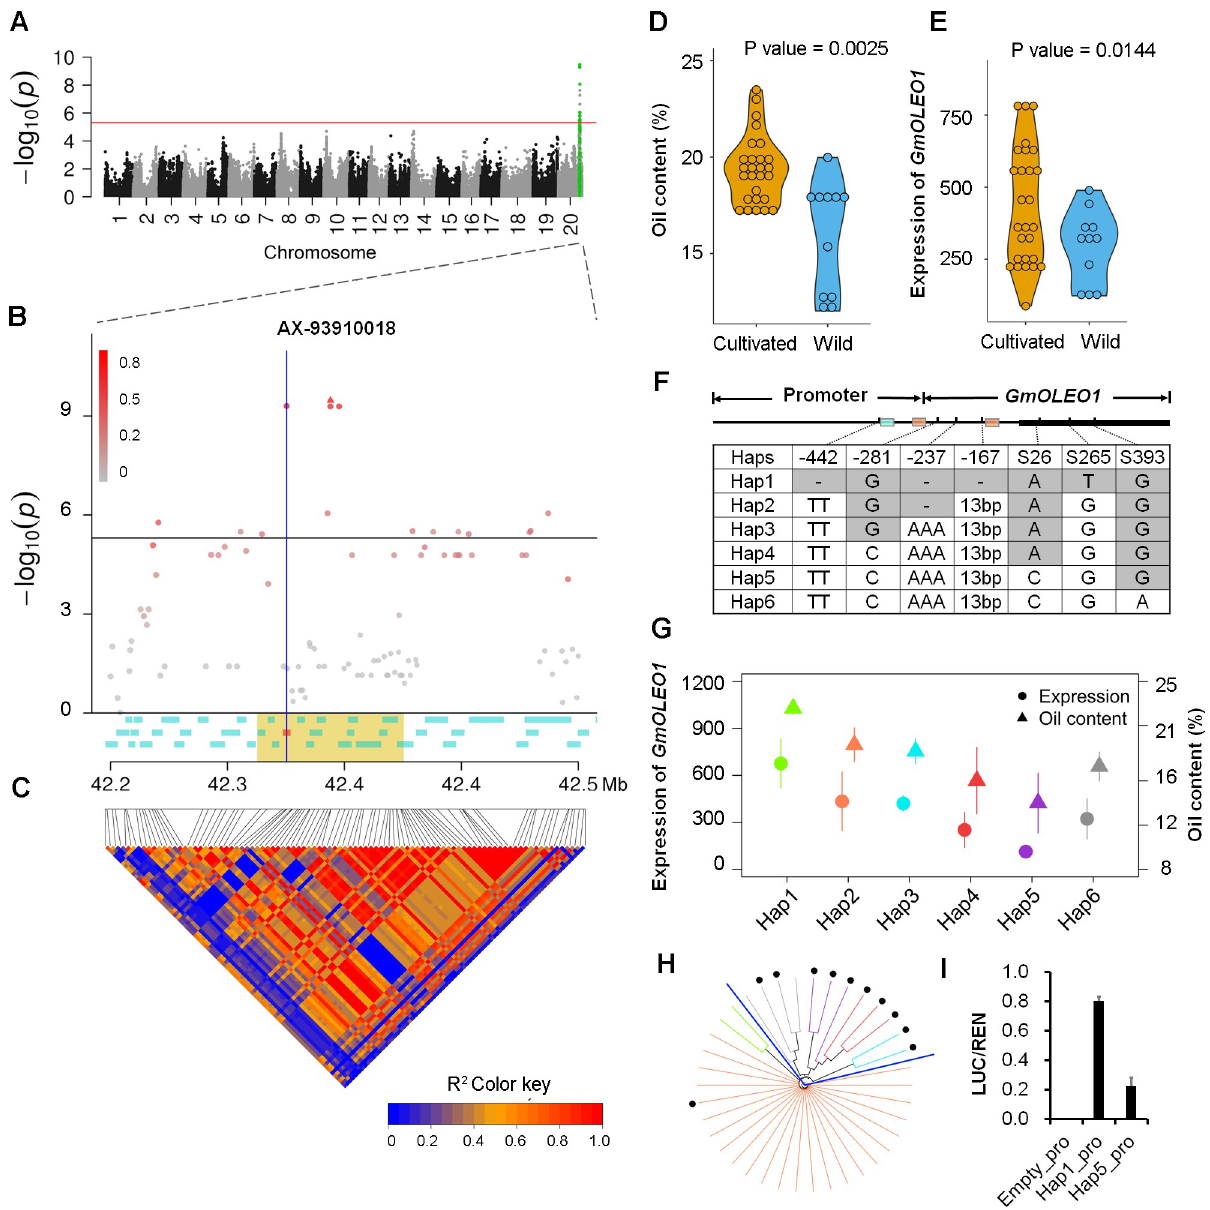
Fig 1. GWAS for oil content in soybean seeds and candidate gene selection analyses. A, A Manhattan plot for the BLUP of soybean oil content across six environments by association mapping. A red horizontal line depicts the Bonferroni-adjusted significance threshold ( P < 4.95 × 10 − 6 ). The x- axis shows the 20 soybean chromosomes, and the y-axis shows the significance expressed as the -log 10 P value. B, A zoomed-in Manhattan plot of the 0.2-Mb genomic region on either side of the most significant SNP at the QTL GqOil20 on chromosome 20. The red solid triangle represents the leading SNP (AX-93910018). The color intensity of other SNPs is shown according to their LDs ( r 2 value) with the leading SNP. Gene models within the region are indicated with blue rectangles, and the red rectangle represents the candidate gene Glyma . 20G196600 . The 50-kb genomic regions on both sides of the leading SNP are highlighted in light yellow. C, The extent of linkage disequilibrium (LD) in the 0.2-Mb genomic region on either side of the leading SNP based on pairwise r 2 values. The r 2 values are indicated using the color intensity index. D, Comparisons of seed oil content (%) between cultivated and wild soybeans. E, Comparison of GmOLEO1 expression between cultivated and wild soybeans. F, haplotypes of GmOLEO1 among 38 soybean genotypes. The orange and cyan rectangles on the promoter region indicate the cis-acting regulatory elements involved in ABA response and seed- specific regulation, respectively. G, Comparative analyses of the GmOLEO1 expression and oil content between the six different haplotypes. H, A neighbor-joining tree of the 38 accessions using variants from GmOLEO1 . The edge color pattern was the same as that indicated by the six different haplotypes in ( G ). Black solid dots represent G . soja accessions. I, Ratios of LUC and REN activity in Arabidopsis protoplasts transformed with recombinant plasmids containing the GmOLEO1 promoters from two different haplotypes (Hap1_pro, Hap5_pro) and the control vector. Significance analysis was performed using Fisher’s protected least significant difference (LSD) test. �� indicates a significant difference at the 0.01